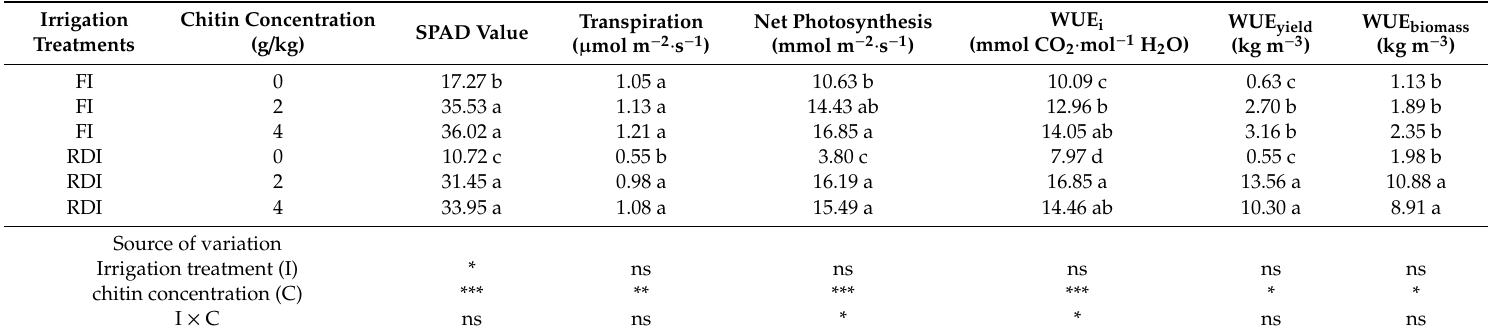
Table 4. E ff ects of di ff erent concentrations of chitin on the photosynthesis and water use e ffi ciency (WUE i , WUE yield , WUE biomass ) of maize under full irrigation (FI) and regulated deficit irrigation